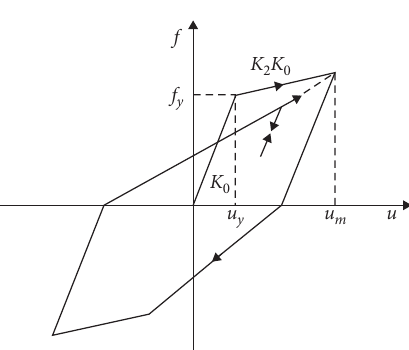
Figure 3: The modified Clough model.